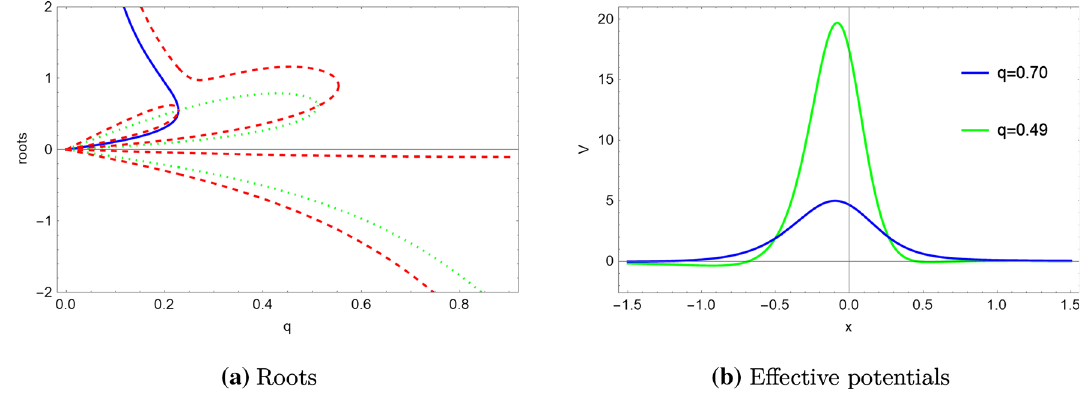
and the effective potentials are asymptotic to 0 − in x → ∞ . The right column presents two examples with negative regions of the effective potentials